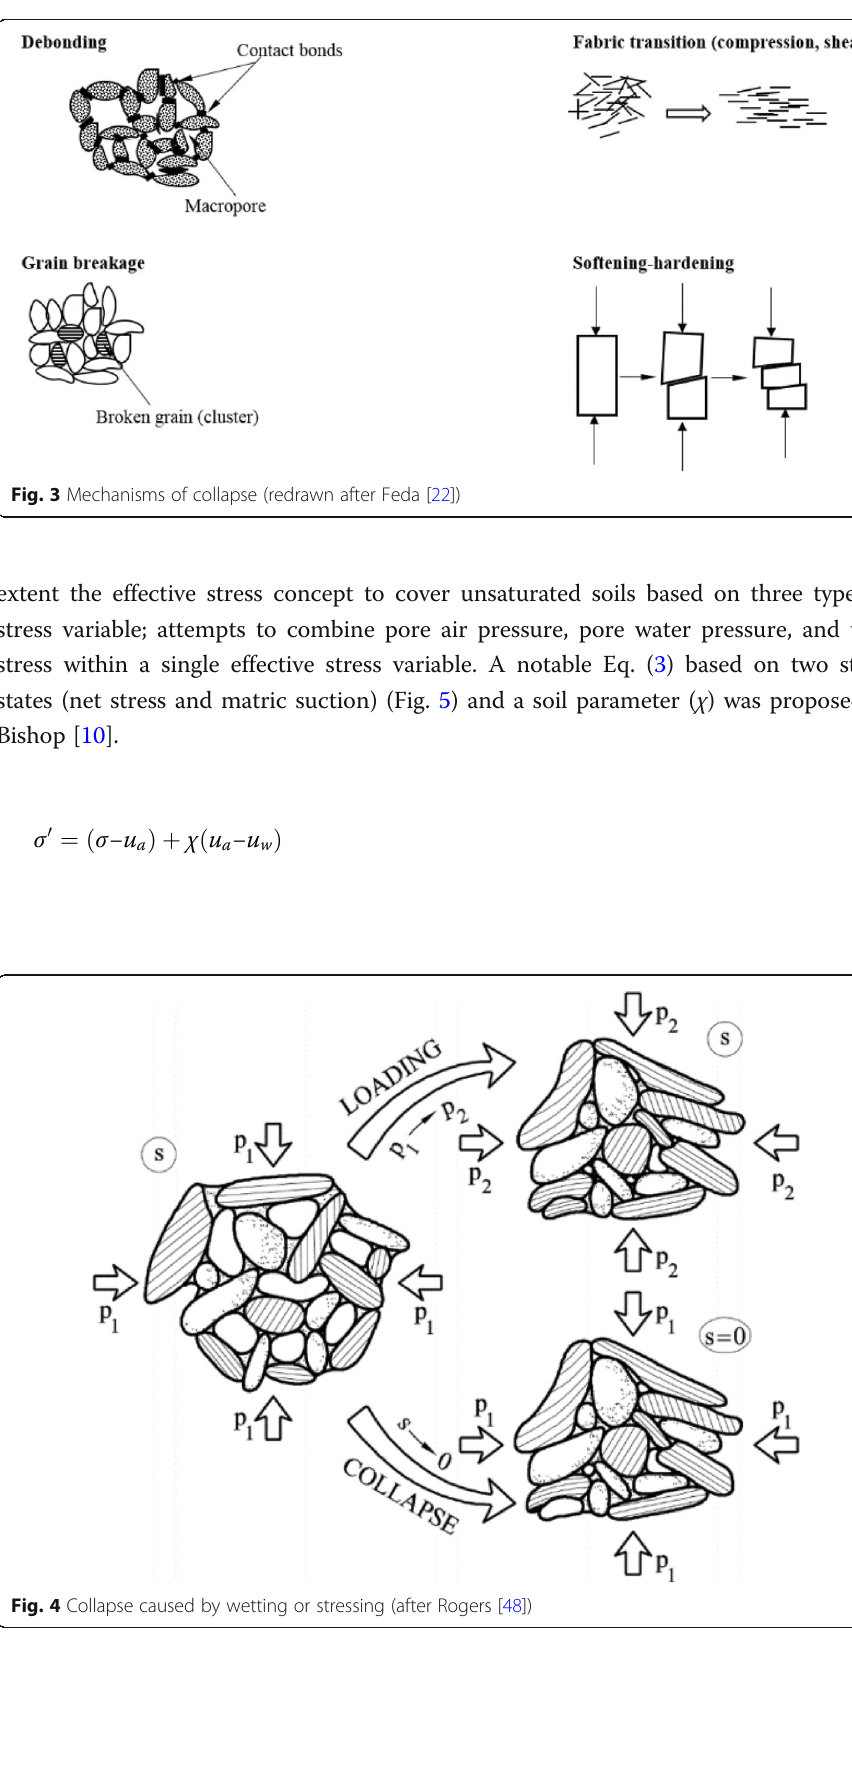
Fig. 4 Collapse caused by wetting or stressing (after Rogers [48])